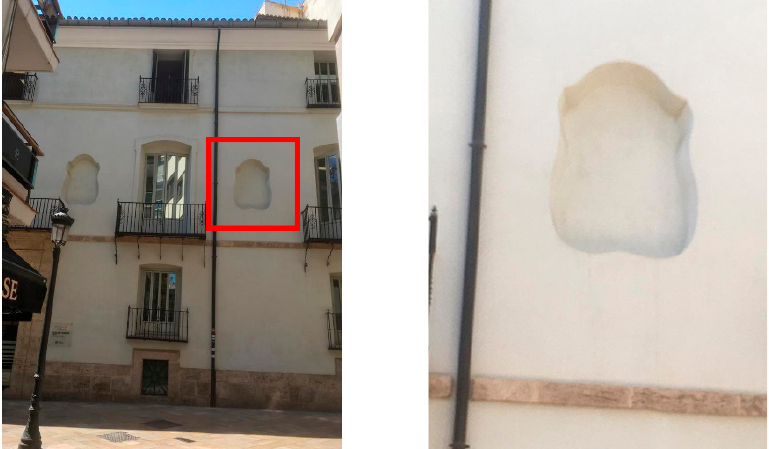
Figure 18. Decorative niches on the façade of the Boil de Arenós Palace, Street of Libreros,